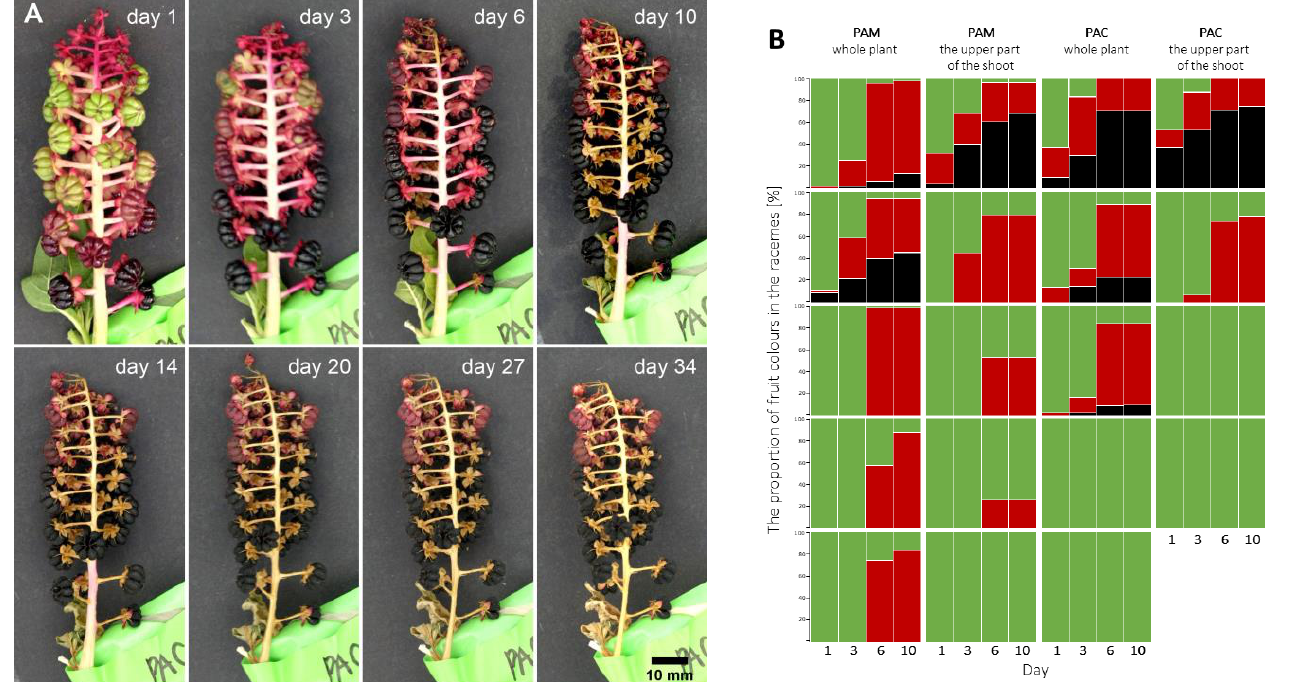
Figure 4. Fruit-ripening experiment on a whole dug-out plant with a cut tap root and a cut made to the upper part of the plant shoot. ( A ) Fruit ripening in the selected raceme of Phytolacca acinosa . ( B ) Summary of the fruit ripening of all observed fruit racemes. The group of 4 columns represents one fruit raceme in 4 days of observations, and the colours show the proportions of fruits of different ripeness (the colours of the columns represent colours of fruits). Legend: PAM— Phytolacca americana ; PAC — P. acinosa .